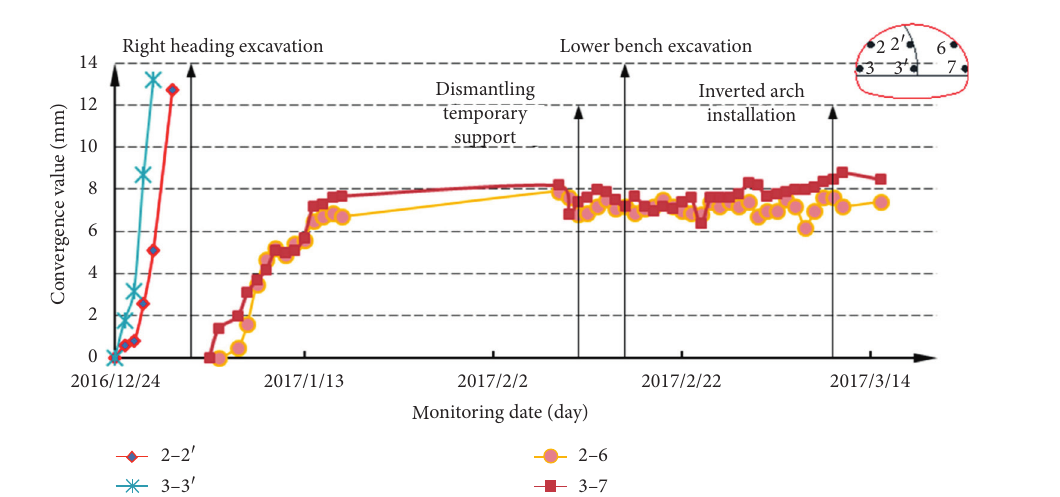
Figure 5: Horizontal convergence temporal curve at section YK2+449.